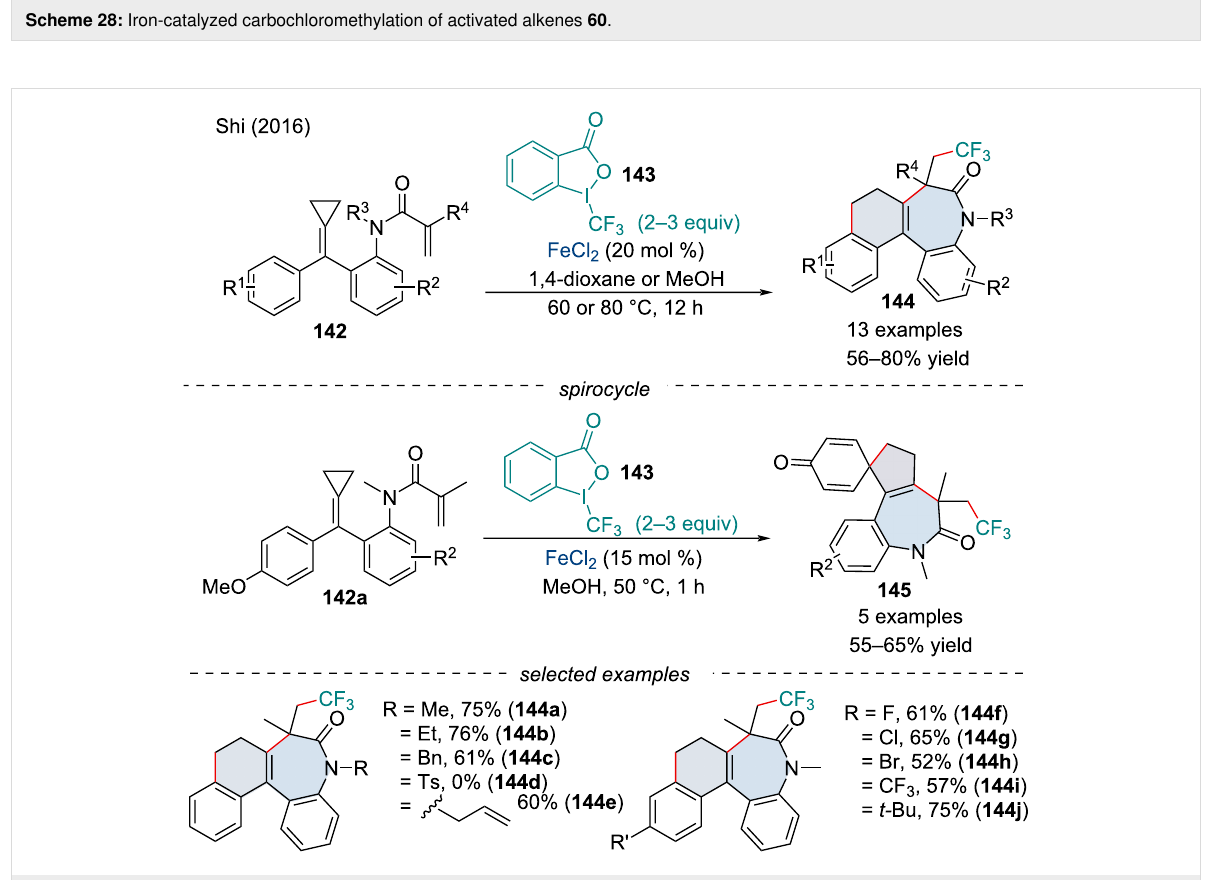
Scheme 29: Iron-catalyzed trifluoromethylation of dienes 142